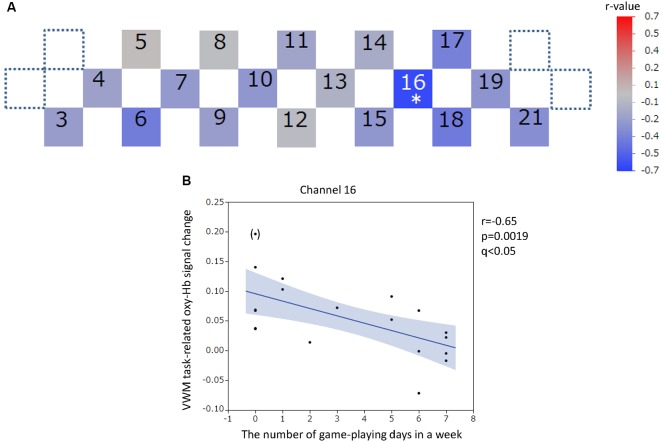
Verbal working memory task-related oxy-hemoglobin signal changes and the number of gaming days in 1 week. Levels of correlation are illustrated by colored squares (A). The color spectrum bar indicates the r-value scale. The channel with statistical significance even after FDR correction is indicated by an asterisk (q < 0.05). The scatter plot with a regression line and 95% confidence interval represents the significant channel (B). An outlier is indicated in parentheses. VWM, Verbal working memory; oxy-Hb, oxy-hemoglobin.